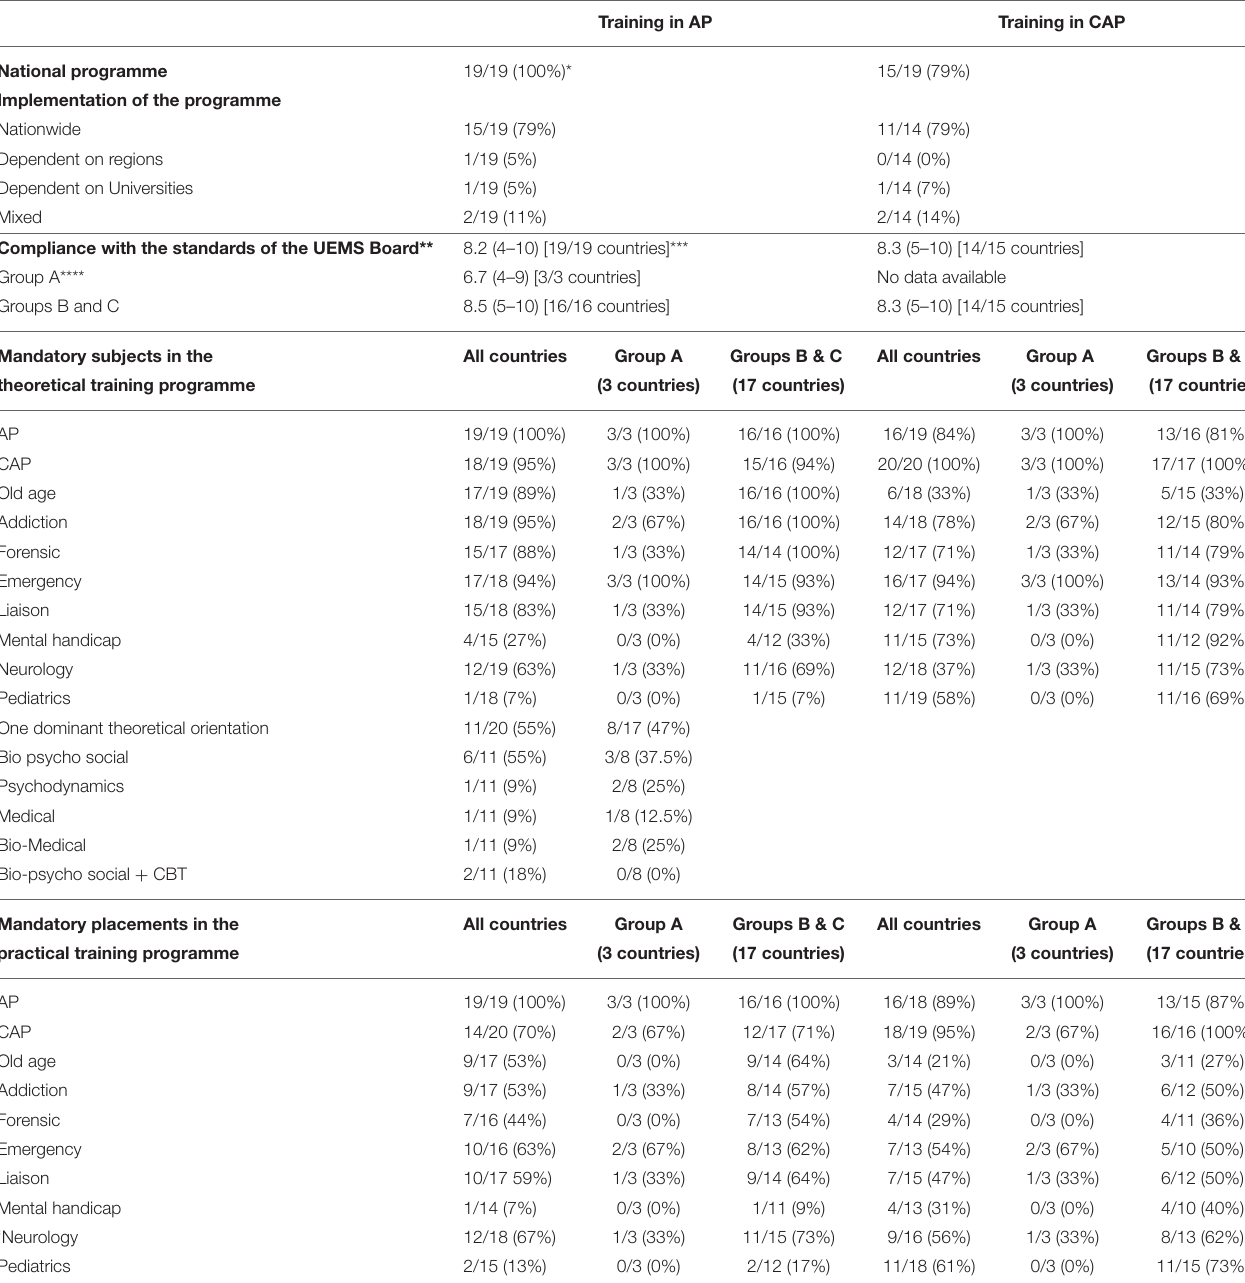
TABLE 2 | Training and specialization in Adult Psychiatry and Child and Adolescent Psychiatry: theoretical and practical content. Training in AP Training in